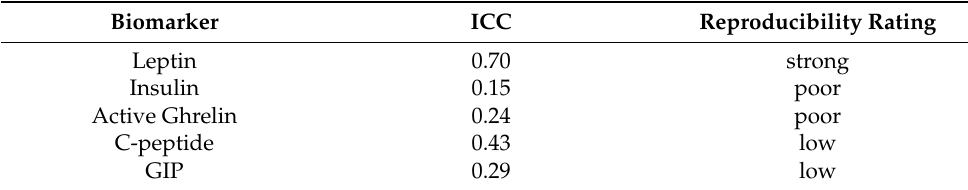
Table 4. ICC of the tear fluid metabolic proteins. Biomarker